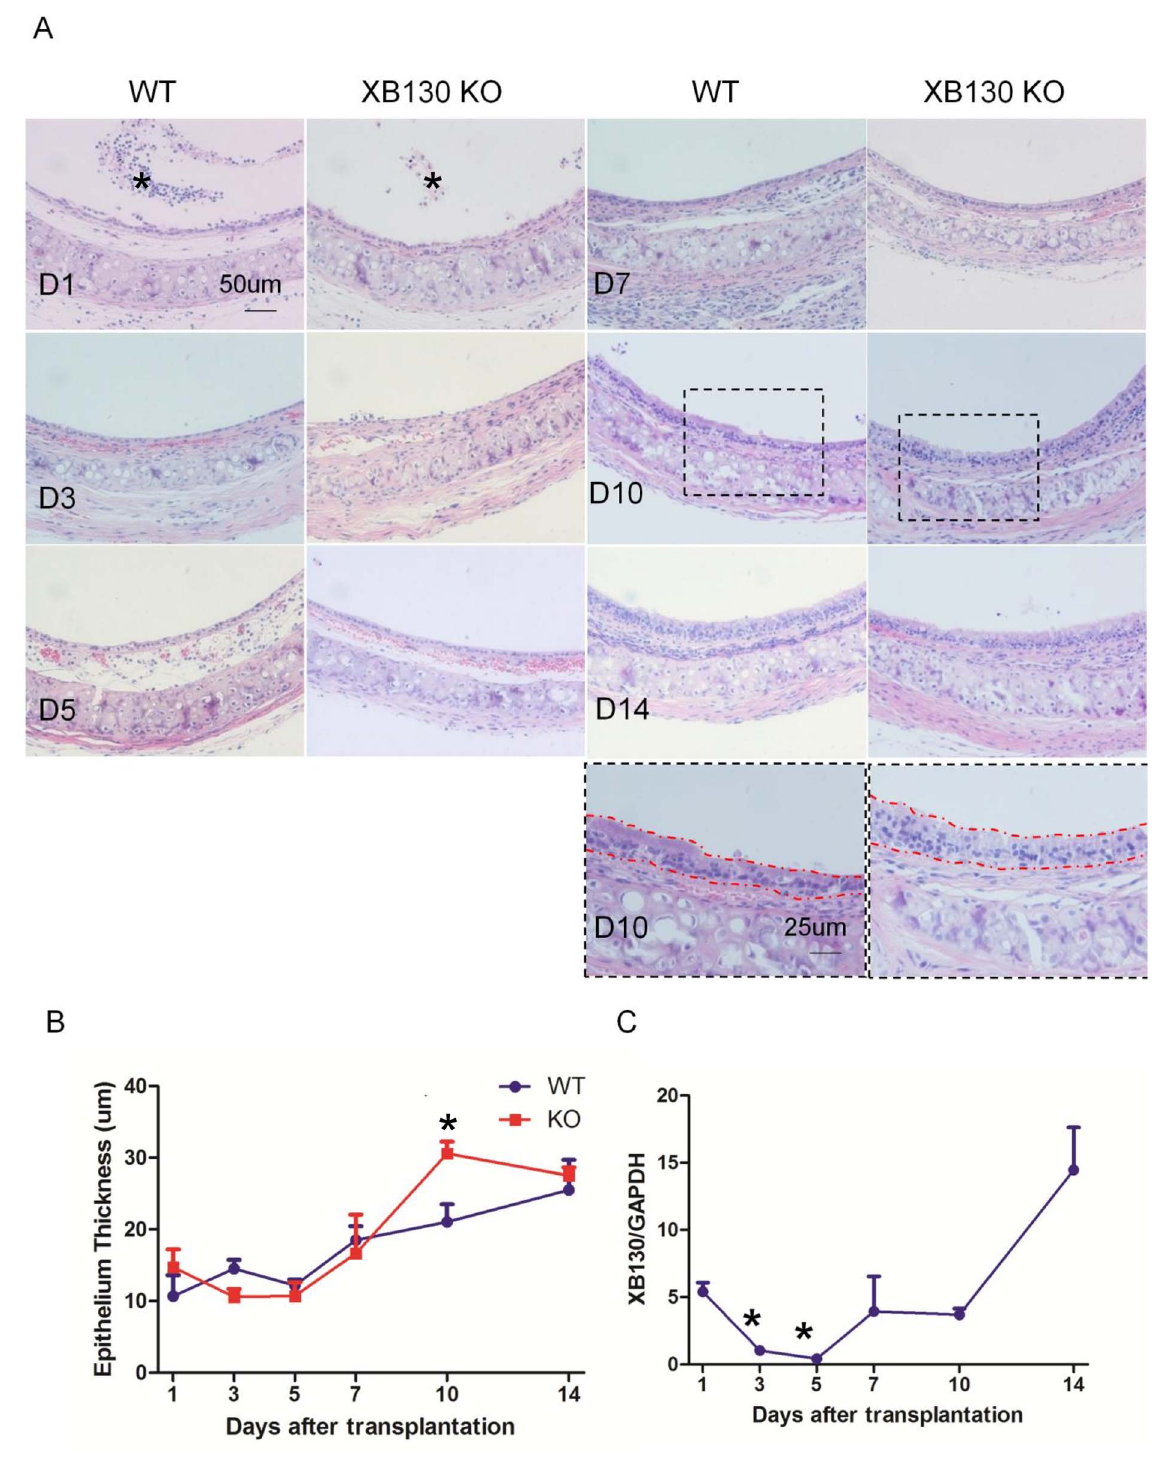
Figure 4. A transient tracheal epithelium hyperplasia is seen in Xb130 KO mice during airway repair after isogenic tracheal subcutaneous transplantation. A dynamic airway epithelium injury and repair process is observed in both WT and Xb130 KO mice (A). One day after tracheal transplantation, many epithelial cells detached from the basement membrane (D1, * the detached epithelial cells). On Day 3, survived epithelial cells became flat and elongated to cover the basement membrane (D3). From Day 5 to Day 7, epithelium was repopulated with cuboidal shaped cells (D5, D7). The epithelial cells were further differentiated towards pseudo-stratified layer (D10, D14). Severe epithelial hyperplasia was noted in KO mice in comparison with WT mice at Day 10 (A and B). After transplantation, XB130 mRNA levels were reduced at Day 3 and Day 5, and then increased afterwards (C).